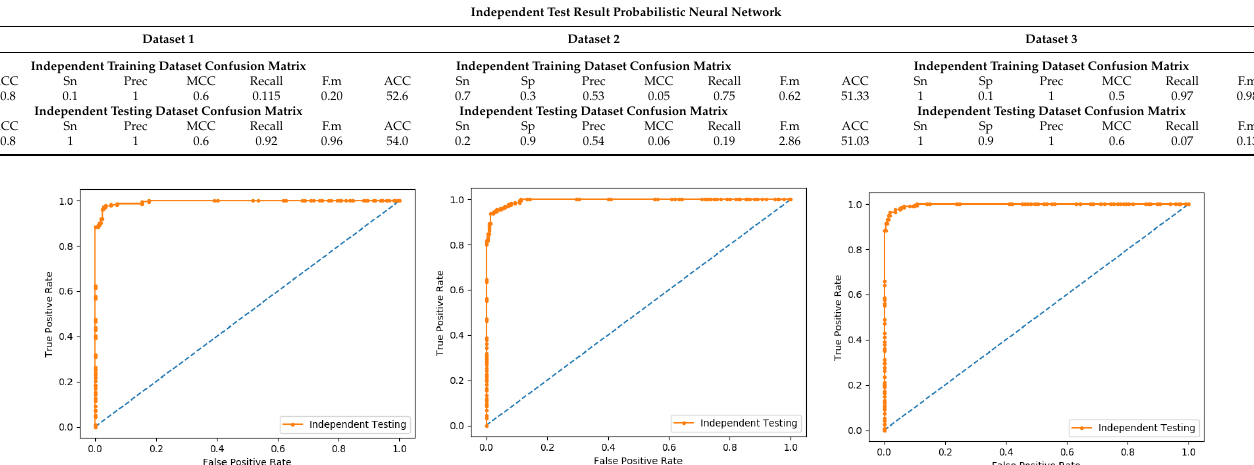
Figure 13. Independent Random Forest ROC curve. Table 9. Result of independent test based on Probabilistic Neural Network.